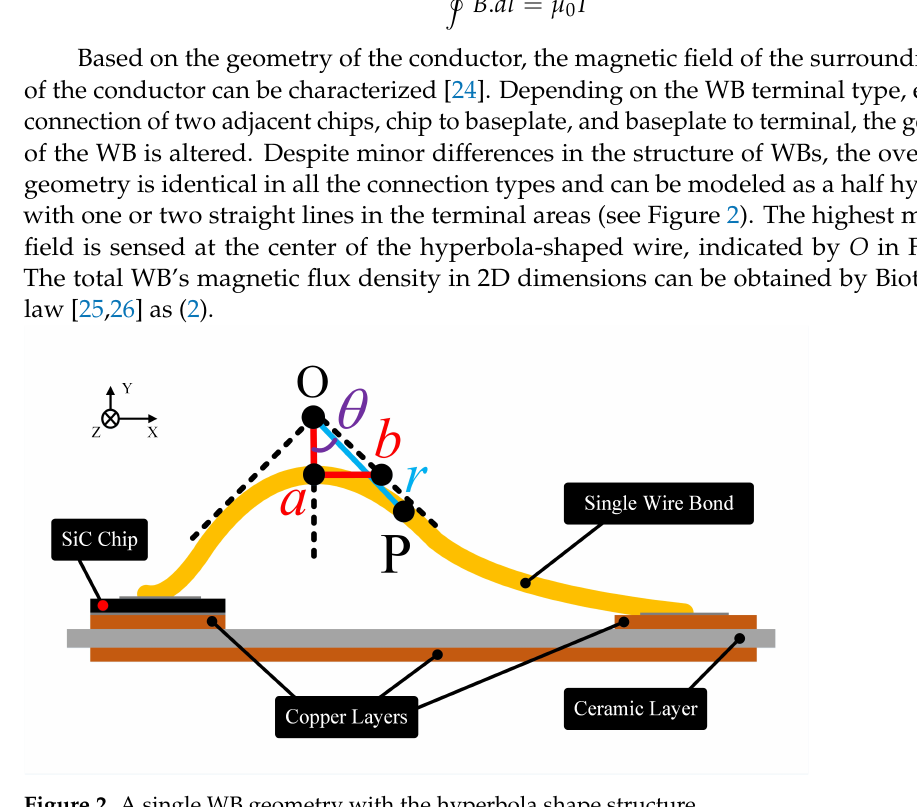
Figure 2. A single WB geometry with the hyperbola shape